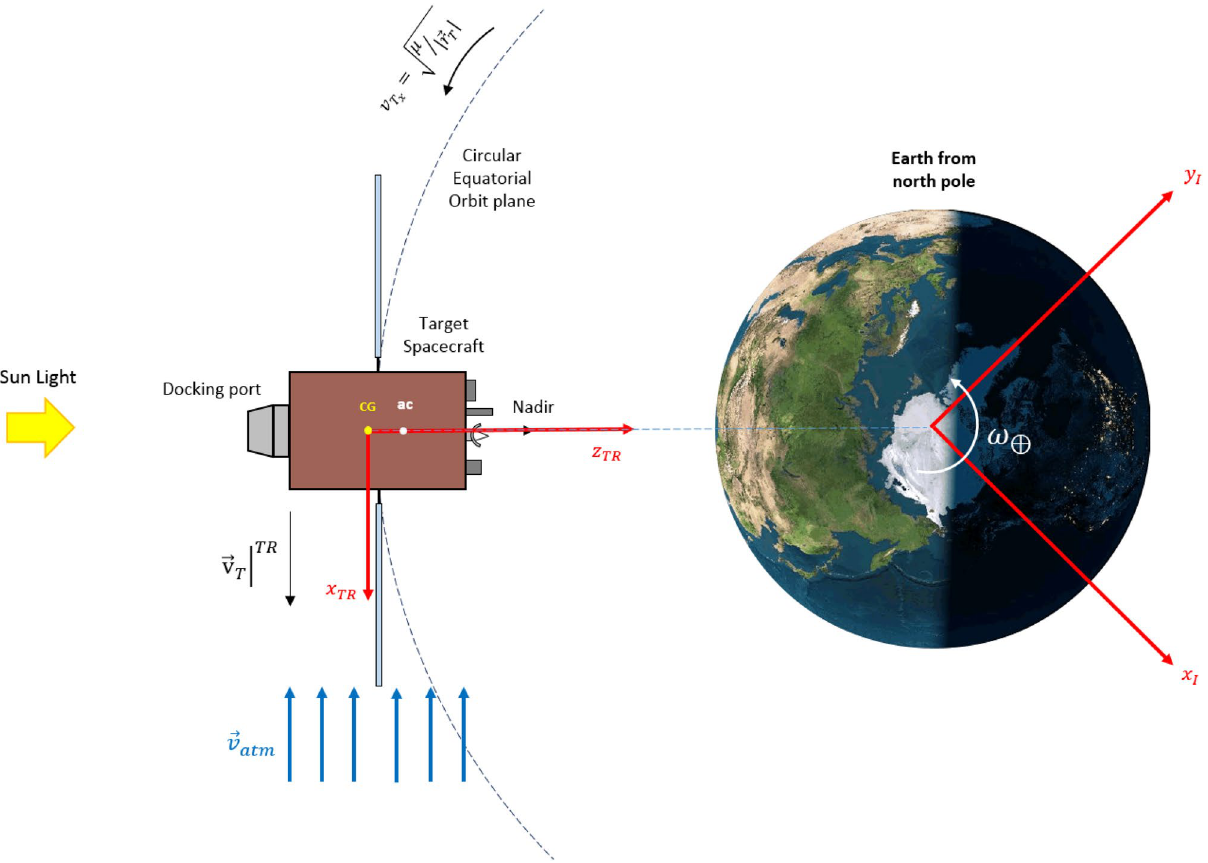
Figure 8. Schematic of target spacecraft motion in the presence of atmosphere